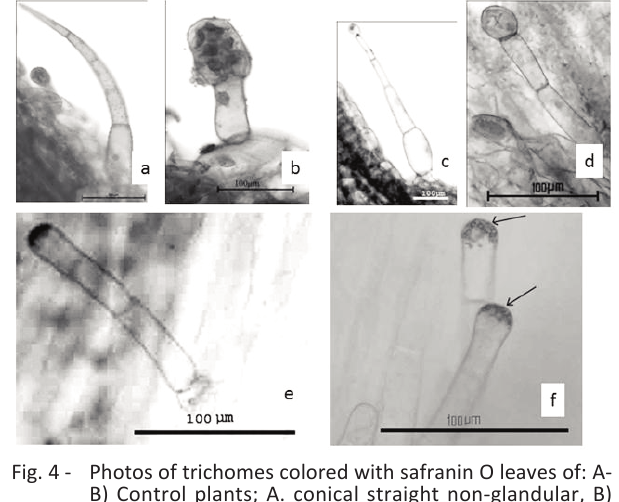
Fig. 4 - Photos of trichomes colored with safranin O leaves of: A- B) Control plants; A. conical straight non-glandular, B) type A. C-D) ‘Draga’ plants treated with 100 mM salt concentration; C) a photo of whole type B-like tri- chomes, D) empty glandular vesicle of the type B-like tri- chomes without any secrets . E-F) ‘Spunta’ plants treated with 100 mM salt secretions; E) a photo of whole type B- like trichomes; F) the glandular vesicle of type B-like tri- chomes secreting green droplets (arrows). Bars=100